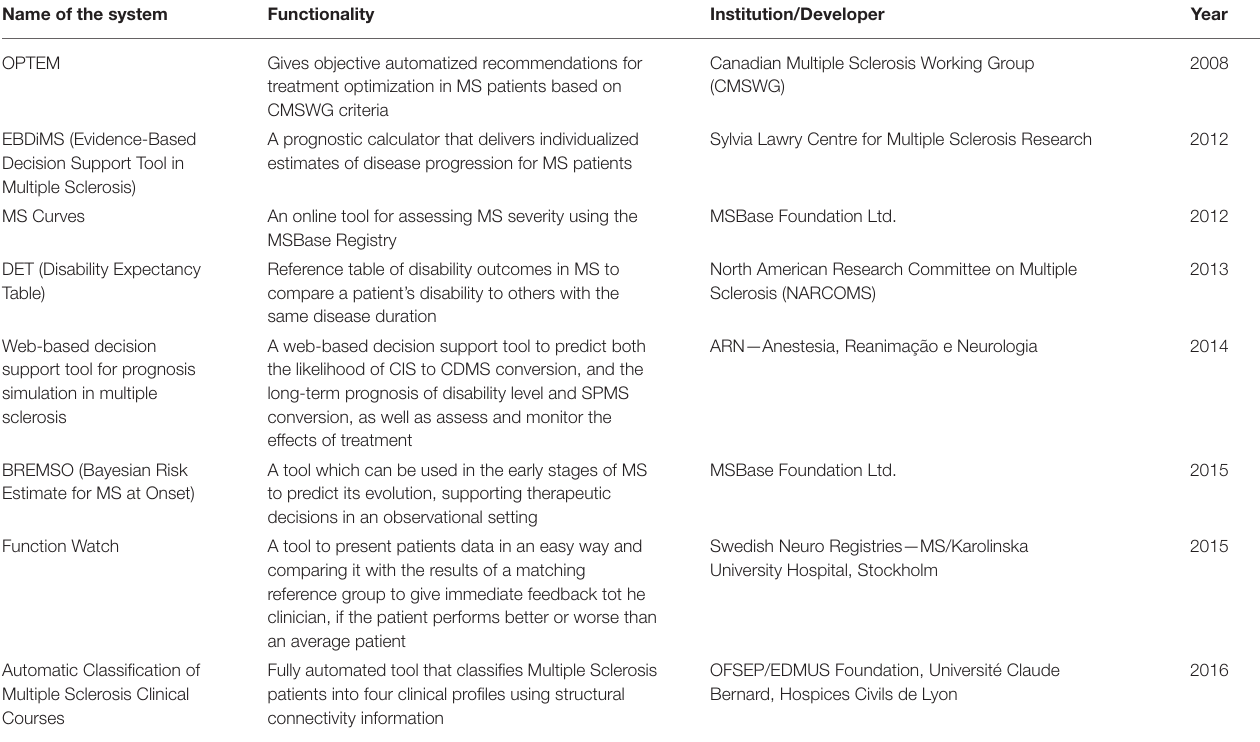
TABLE 2 | Digital support systems to support doctors in their therapy decisions